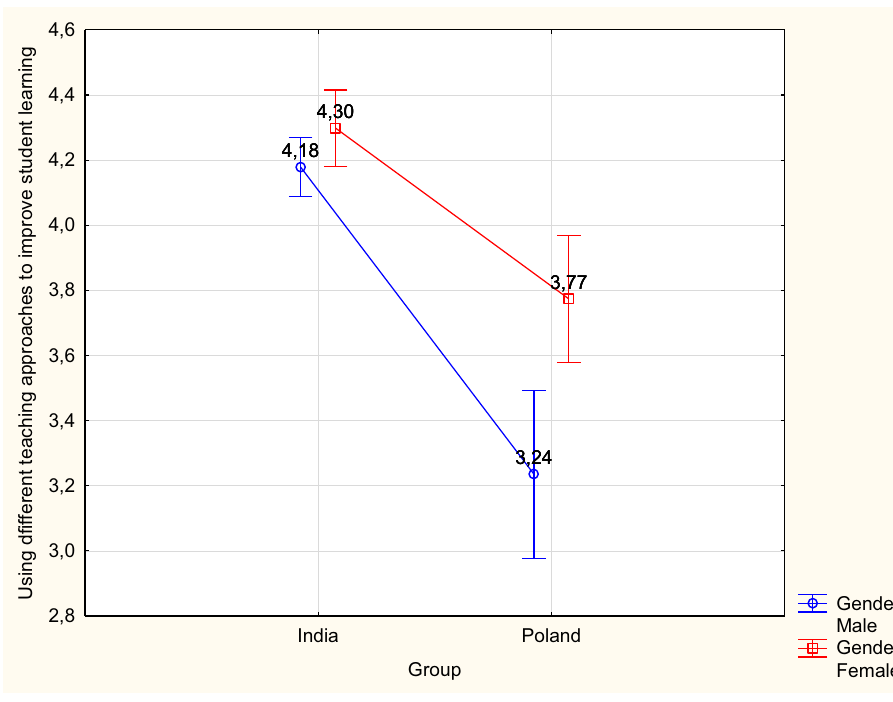
Figure 1. The mean values with a 95% confidence interval for the average value of the TA dimension by gender and